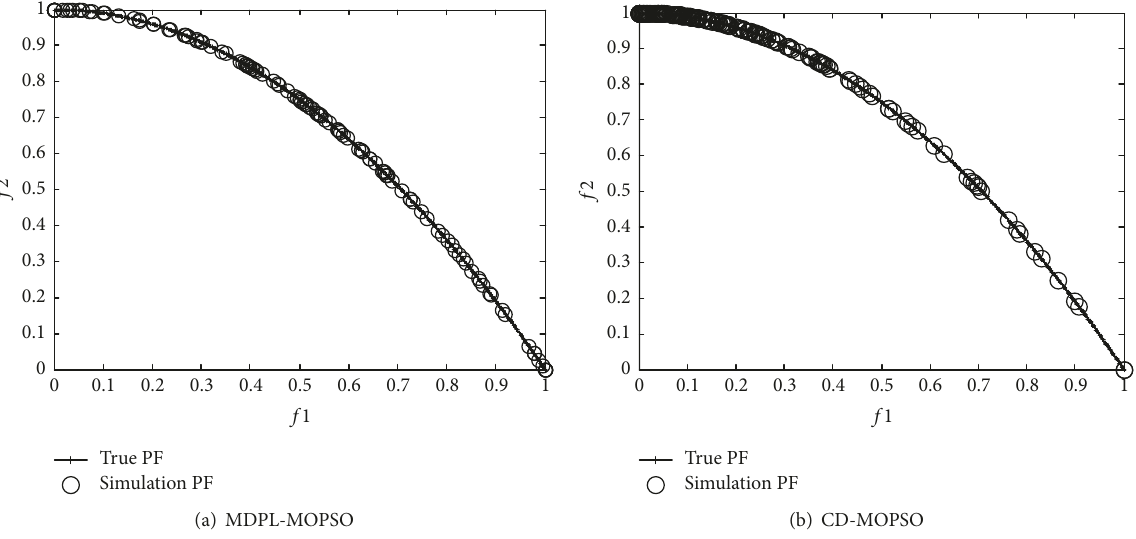
Figure 9: Nondominated solutions with MDPL-MOPSO and CD-MOPSO on ZDT2.